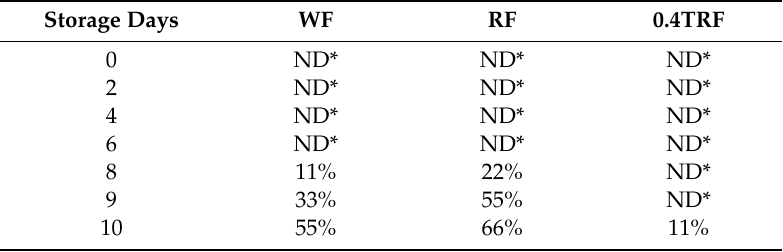
Table 4. Storage observation on crust mold appearance percentage on cake surface.